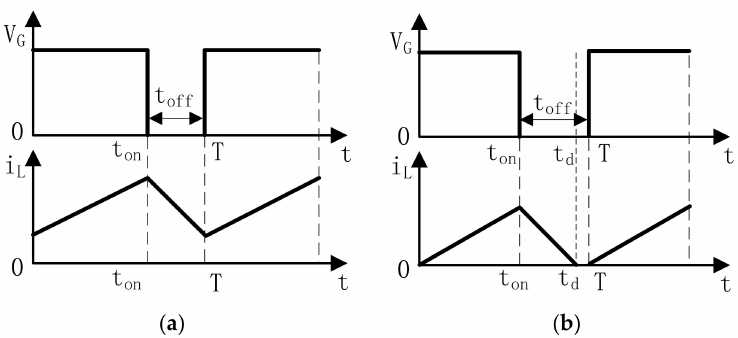
Figure 5. Two operating mode of DC-DC converter ( a ) Continuous current mode (CCM) ( b ) discontinuous current mode